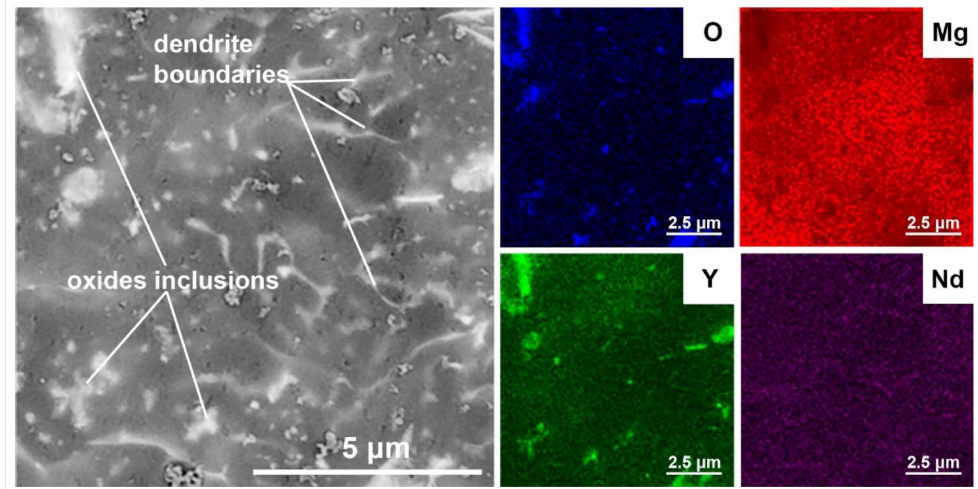
Figure 7. SEM image and EDS maps of elements distribution inside the 3D-printed